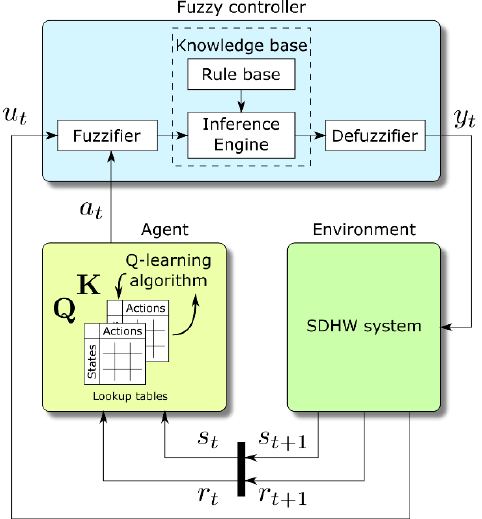
Figure 2. The combination of the Q-learning algorithm and the fuzzy logic controller.